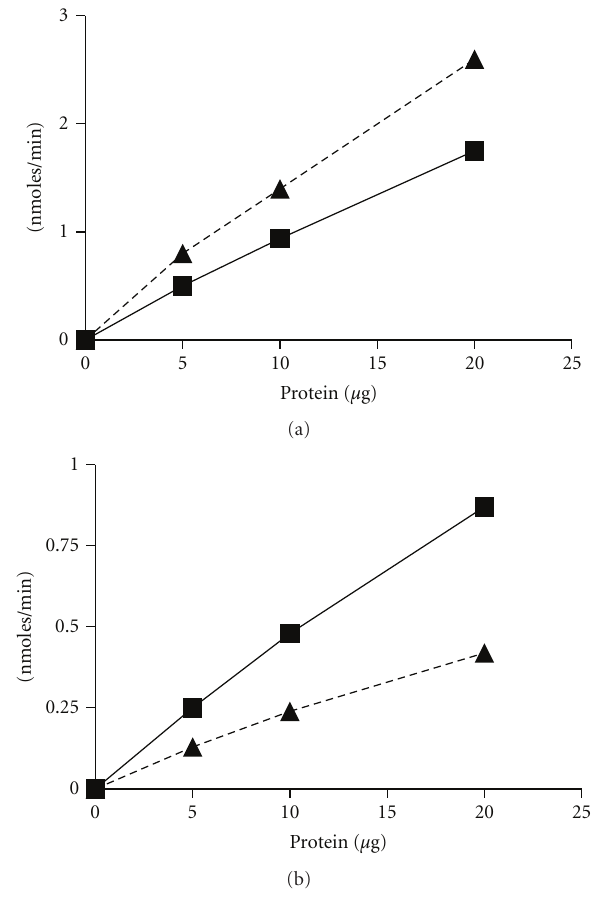
Figure 5: Detection of TAT activity in the forward and reverse directions. Both graphs show the correlation between reaction rate and the amount of enzyme added to the reaction. (a) shows the synthesis of 4-hydroxyphenylpyruvate (square) and phenylpyruvate (triangle) in the forward direction, while (b) shows the synthe- sis of 2-ketoglutarate synthesized from 4-hyrdoxyphenylpyruvate (square) and phenylpyruvate (triangle) in the reverse direction. The standard assays used for this analysis are described in Section